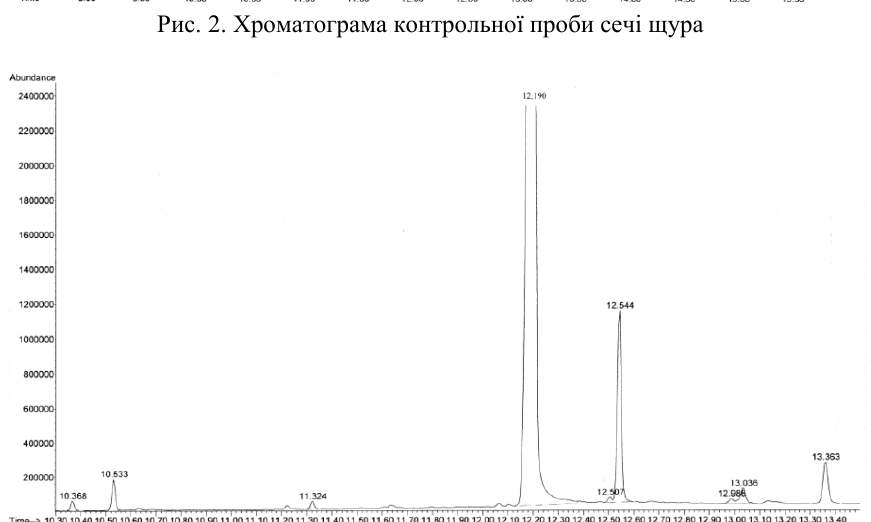
Рис. 2. Хроматограма контрольної проби сечі щура